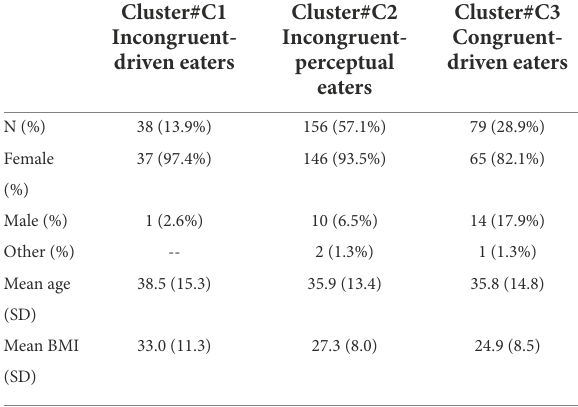
TABLE 2 Clusters’ sociodemographic characteristics and